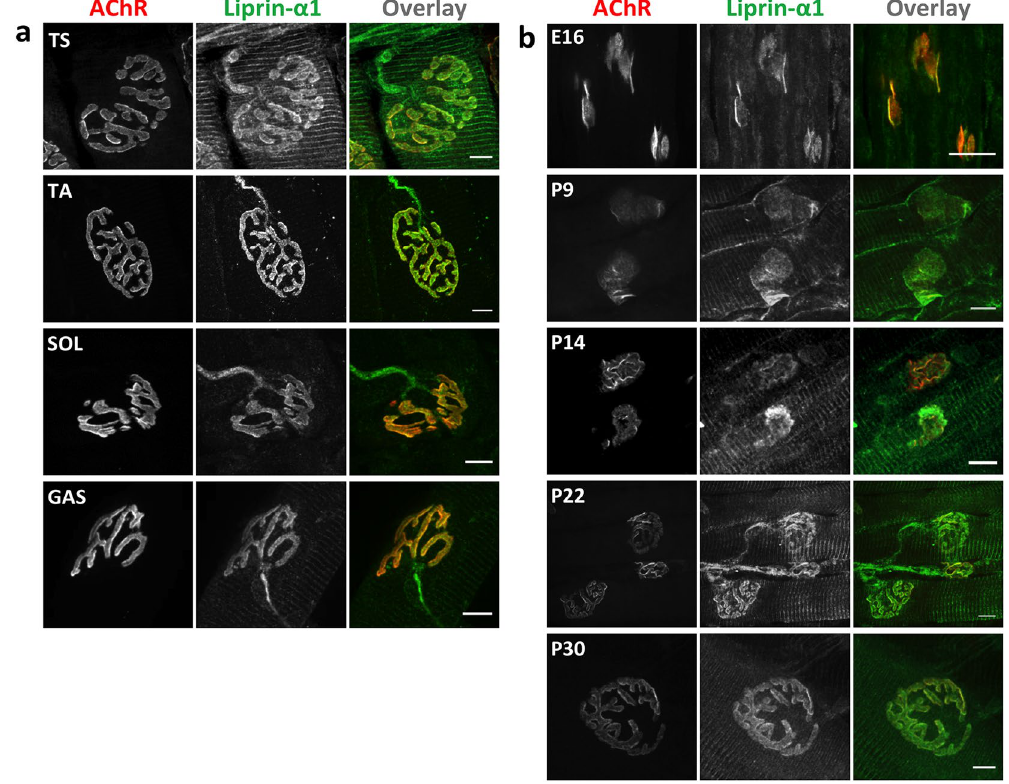
Figure 2. Localization of liprin- α -1 is similar in various muscles and maintained throughout the development. ( a ) Liprin- α -1 immunoreactivity in different muscles. TS, triangularis sterni; TA, tibialis anterior; SOL, soleus; GAS, gastrocnemius. Muscles were collected on P30. ( b ) Immunohistochemical analysis of TA muscle fibers on the indicated embryonic (E) and postnatal (P) days. Anti-liprin- α -1 antibody (green); AChR (red). Scale bar 10 μ